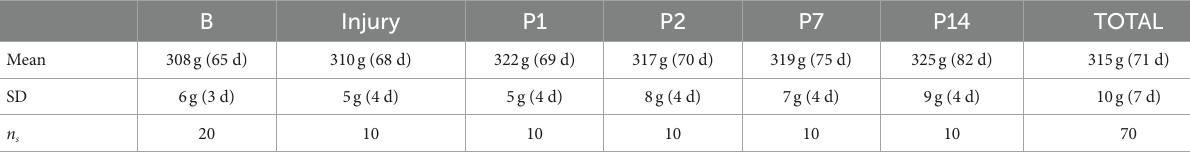
TABLE 1 Animal bodyweight (g) and age (d) on day of MRI and drop-weight injury.